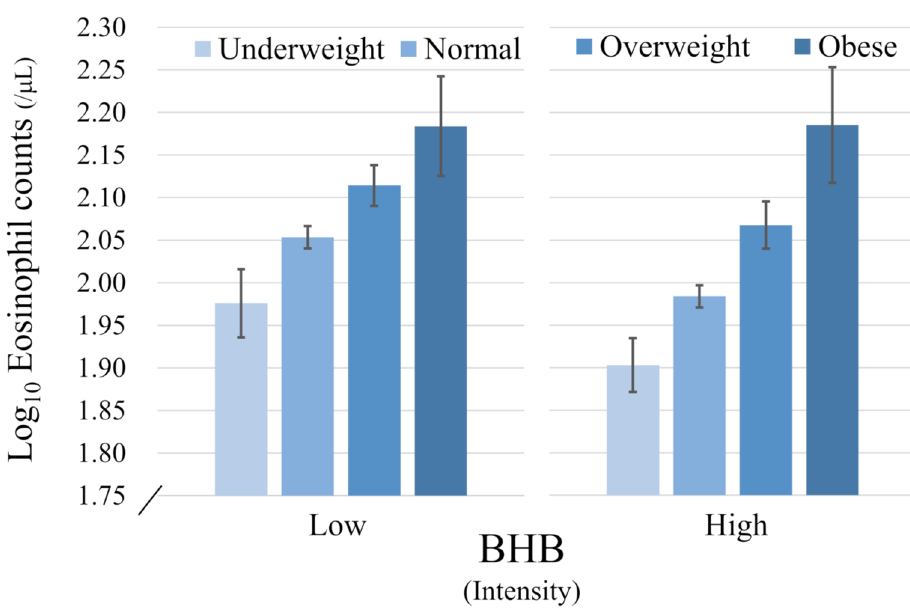
Figure 4. Association of blood eosinophil counts with serum BHB levels and BMI levels: underweight, 18.5 > BMI (kg/m 2 ); normal, 25 > BMI ≥ 18.5 (kg/m 2 ); overweight, 30 > BMI ≥ 25 (kg/m 2 ); obese, BMI ≥ 30 (kg/m 2 ). Subjects with log-transformed BHB < median were categorized as “low BHB” and those with log- transformed BHB ≥ median were categorized as “high BHB.” Log-transformed blood eosinophil counts and serum BHB levels were used for the analysis. Means (95% confidence interval) are